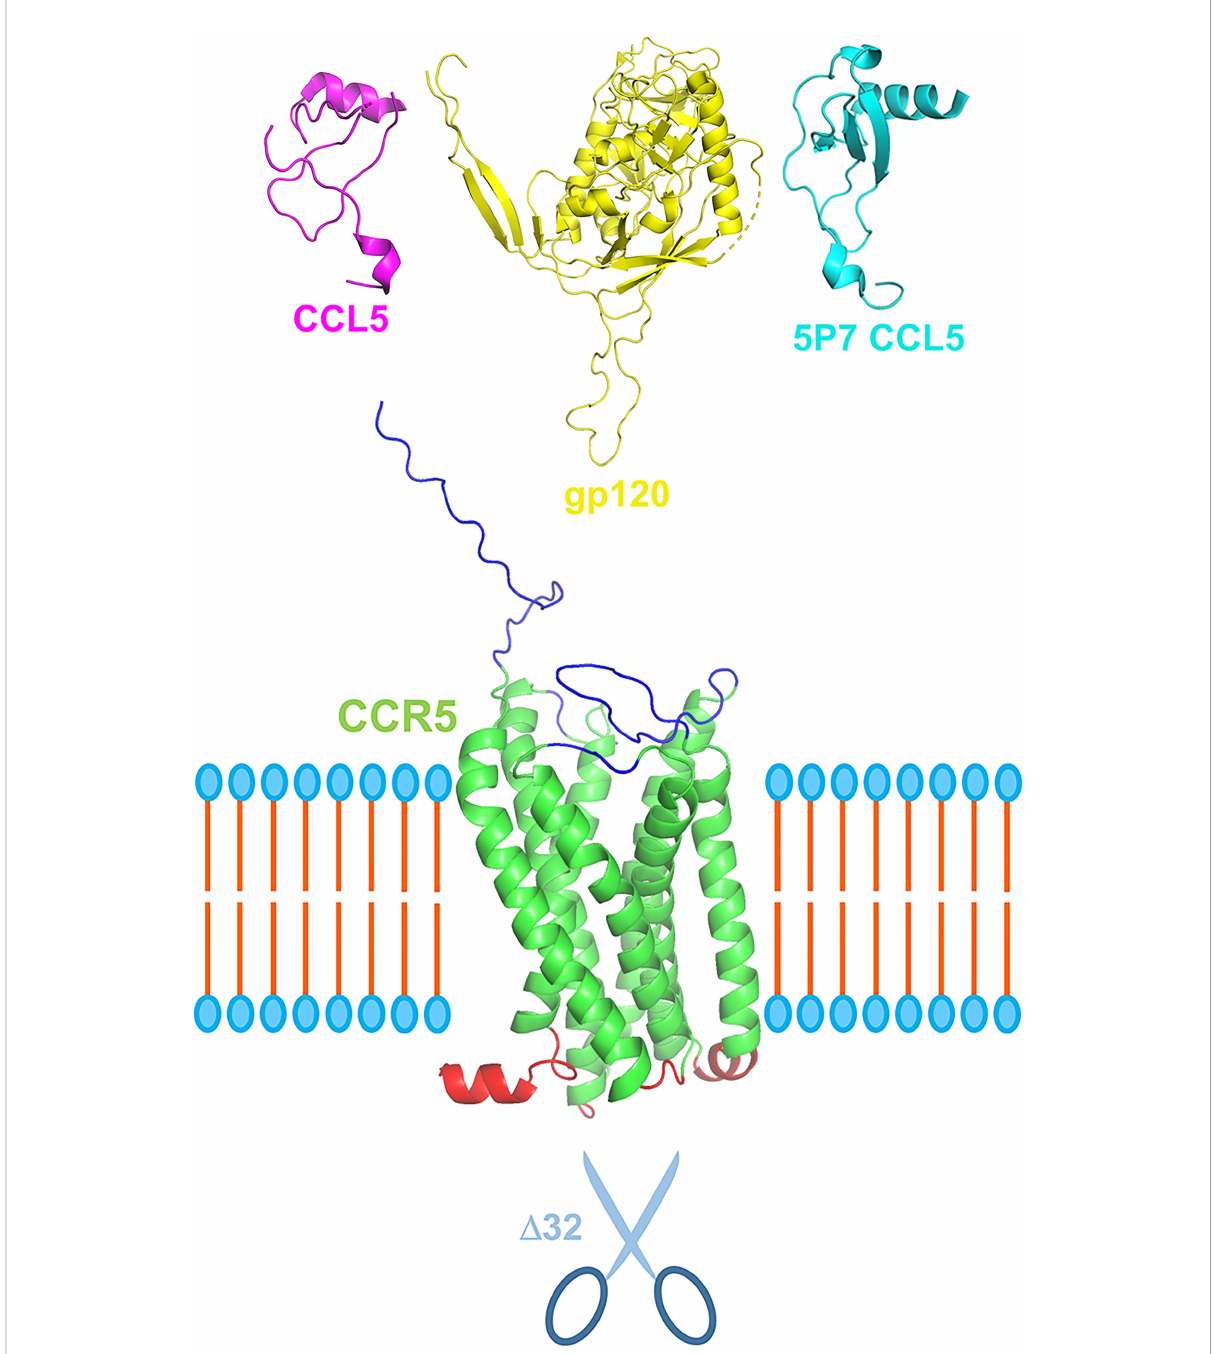
FIGURE 1 Schematic representation of CCR5 in its central role in pathophysiology. CCR5 (green), depicted here with extracellular portions in blue and intracellular in red, can be engaged by its natural ligands, e.g., CCL5 (purple), but also by HIV-1 gp120 (yellow) via its V3 loop. CCR5 antagonists, e.g., 5P7 CCL5 (light blue), can block the receptor in its inactive form preventing receptor internalization and engagement by HIV-1 gp120. More in general, CCR5 antagonists such as chemokine derivatives, small chemical compound (e.g., maraviroc) and monoclonal antibodies (e.g., leronlimab) could provide a therapeutic landscape for the array of infectious and in fl ammatory diseases in which CCR5 plays a central role. Scissors represent the CCR5 D 32 deletion variant that confers resistance to HIV-1 infection and proved relevant for other CCR5-centered diseases. Three dimensional ribbon representation were generated using PyMOL: CCR5 and gp120 from PDB entry 6MEO, CCL5 from 7F1R, and 5P7 CCL5 from 5UIW. The relative sizes of the different proteins are not to scale. The cell membrane bilayer is